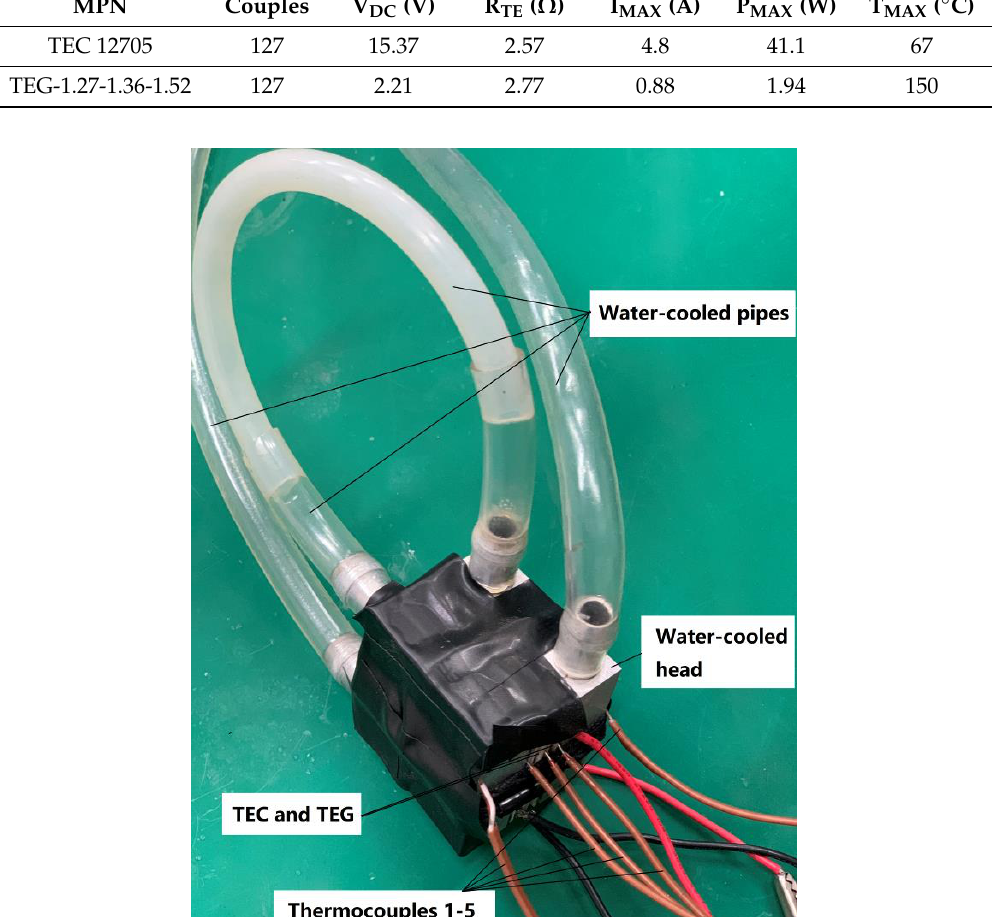
Table 1. Parameters of TEC-12705 and TEG-1.27-1.36-1.52 modules of TECooler.